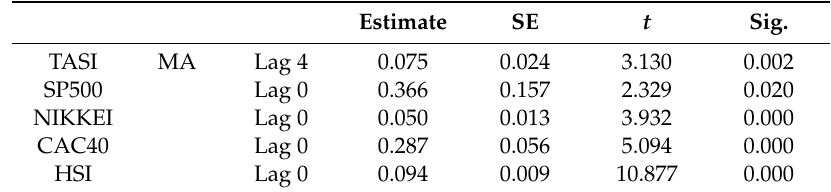
Table 6. Estimation of parameters for ARIMA (0,1,14).